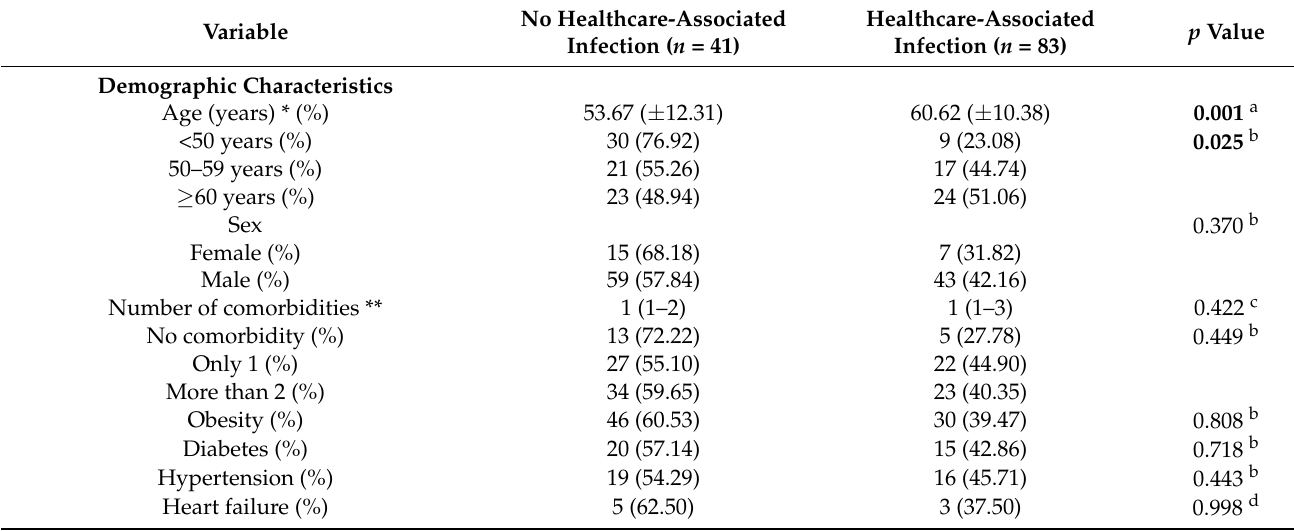
Table 3. Clinical and laboratory characteristics of the study population and comparison between those who did and did not develop a healthcare-associated